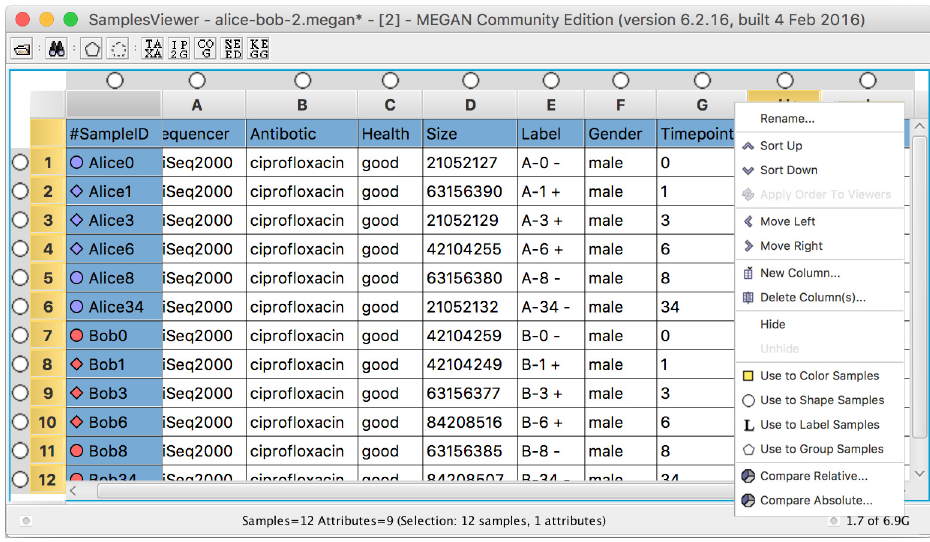
Fig 3. Spreadsheet for entry and analysis of metadata associated with